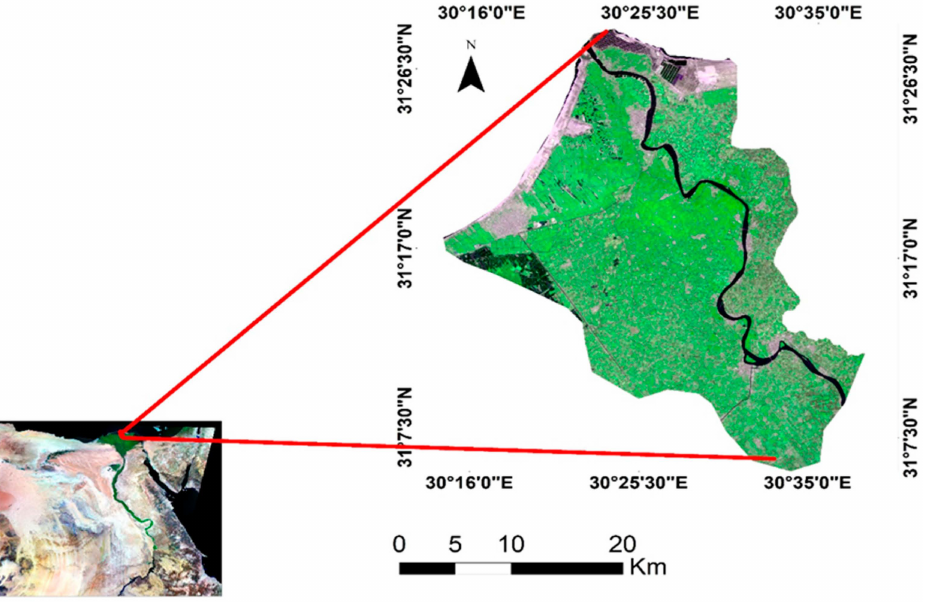
Figure 1. Location of the investigated